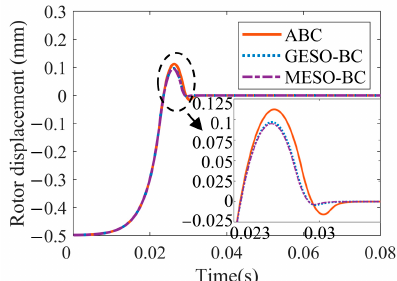
Figure 4. Floating performance simulation results.